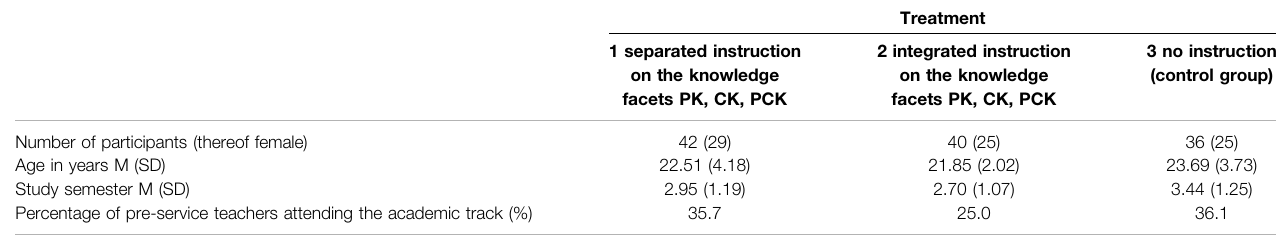
TABLE 1| Overview ofpre-serviceteachers ’ background characteristics within thetreatments ( N total (cid:1) 118). Themean valuewasgivenforage in yearsand study semester.